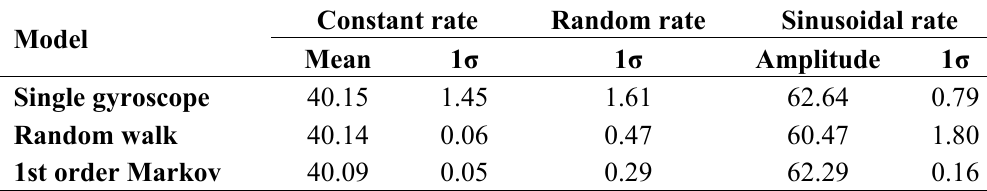
Table 3. Dynamic test results of the virtual gyroscope (unit: